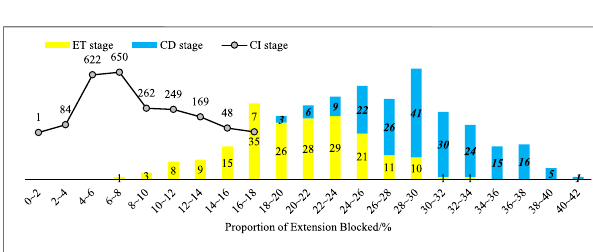
FIGURE 3 | Distribution of fracture stages with different proportions of extension blocked time.